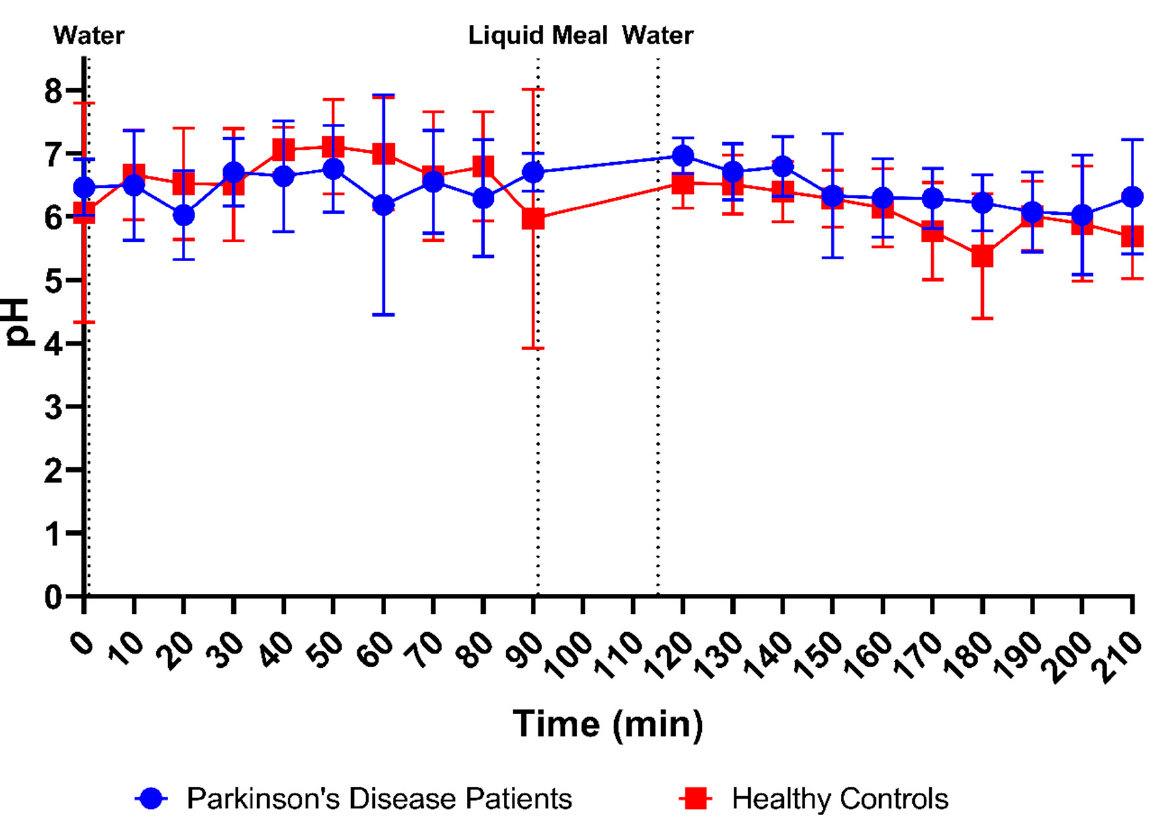
Figure 4. Time-dependent evolution of the pH in duodenal fluids aspirated from Parkinson’s disease patients ( n = 9, blue circles) and healthy controls ( n = 9, red squares). Data points represent the mean ± standard deviation; vertical dotted lines indicate the ingestion of 100 mL of water or 200 mL of liquid meal.